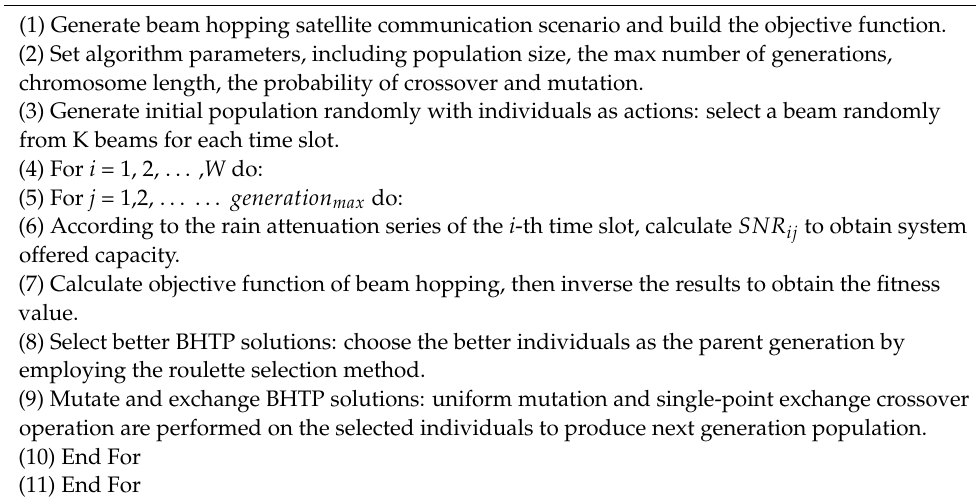
Algorithm 1. Dynamic Time Slots Allocation based on GA under time-varying rain attenuation.